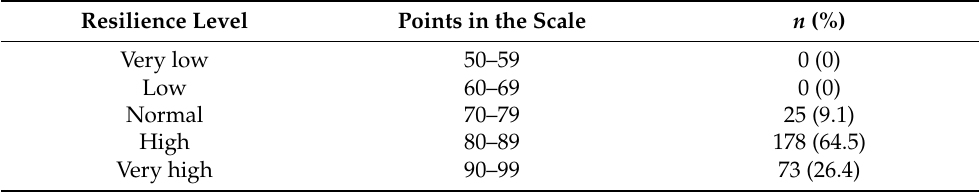
Table 3. Distribution of participants according to level of resilience.